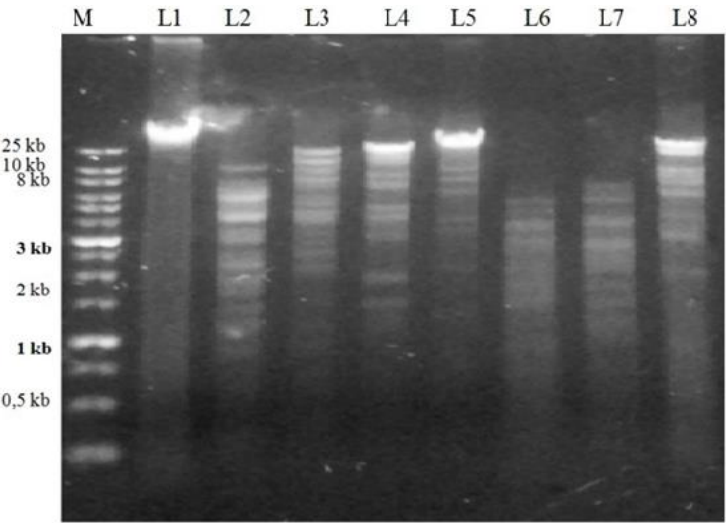
Figure 2. Restriction enzyme-digested fragments of the genomic DNA of A. hydrophila -phage 2.